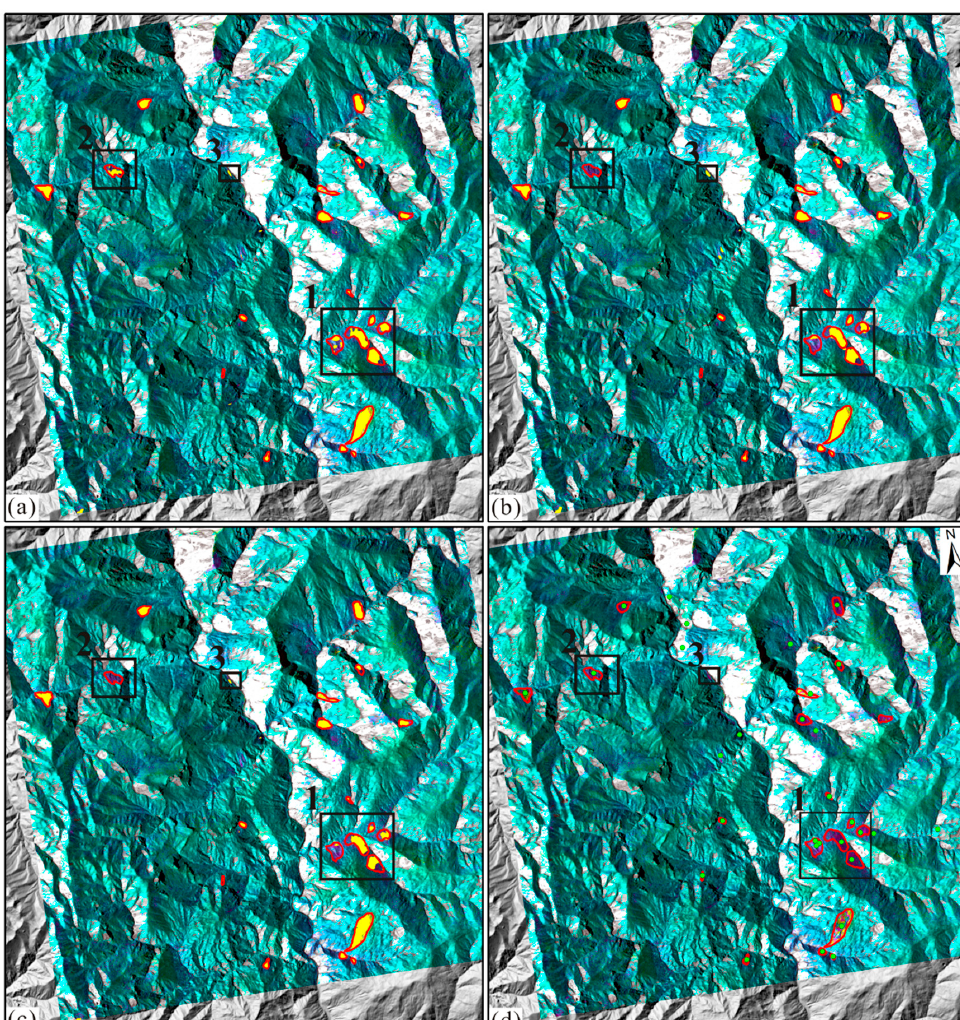
Figure 11. Results of the Zhongxinrong County section of the Jinsha River. The yellow patches in ( a – c ) represent the landslides extraction of DRs-UNet, U-Net, and SegNet, respectively. Red polygons in ( a – d ) indicate ground truth. Green dots superimposed on ( d ) represent the recognition results of the pre-study [39].